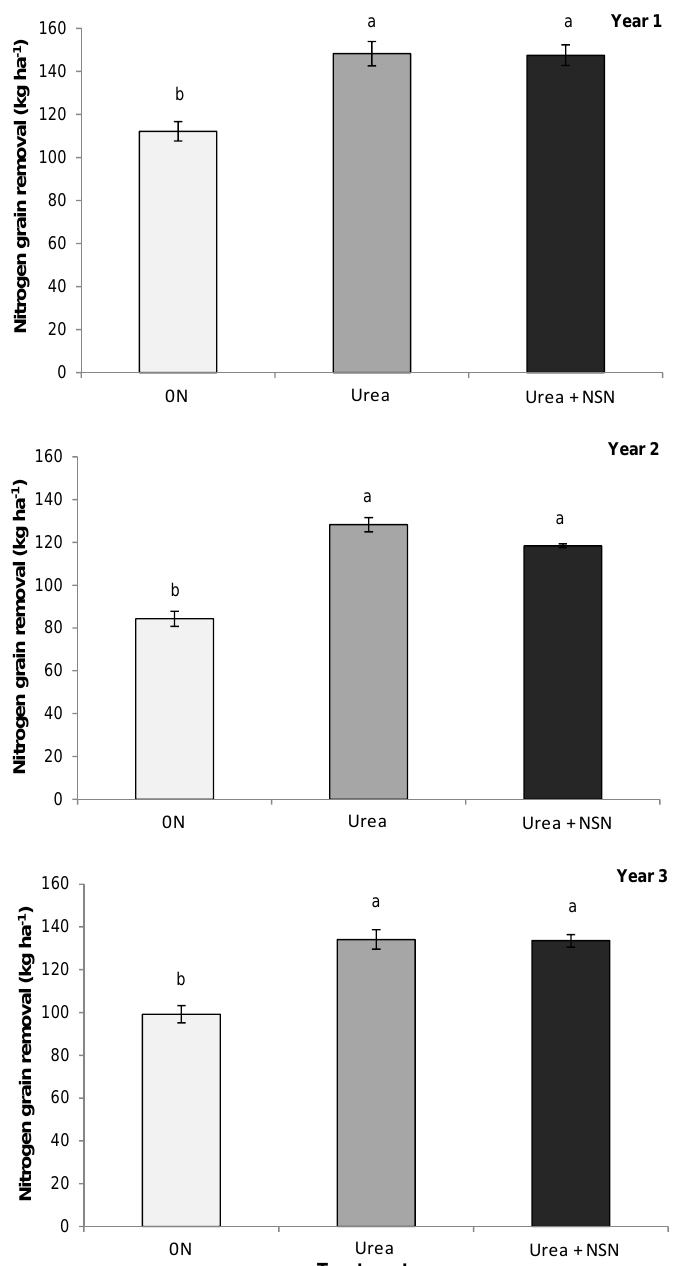
Figure 5. Nitrogen grain removal affected by the N rate and urea or urea treated with NSN (urea + NSN) applied broadcast on the surface during three growing seasons to no-till corn. Means followed by the same letter are not significantly different from each other based on the LSD test (0.05). Vertical bars indicate standard error. NSN, maleic itaconic acid.